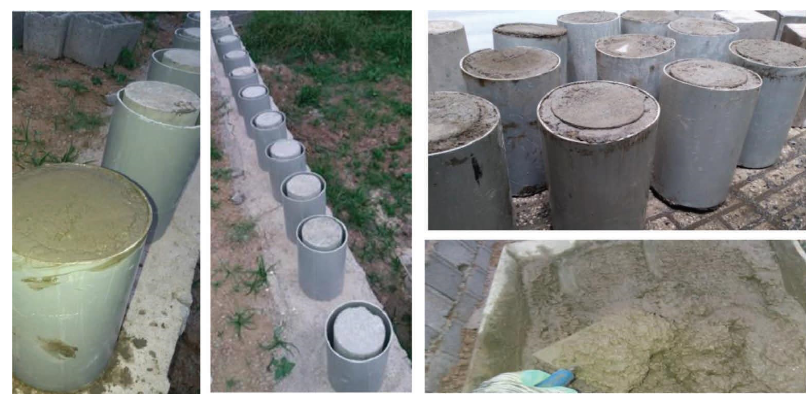
Figure 4: Pictures of the manufacturing stages of cylindrical samples.